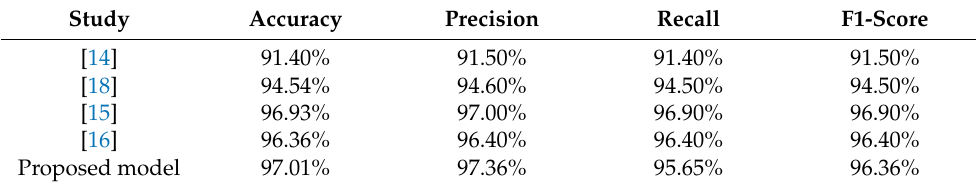
Table 11. Comparison of our proposed classifier with state-of-the-art methods. Study